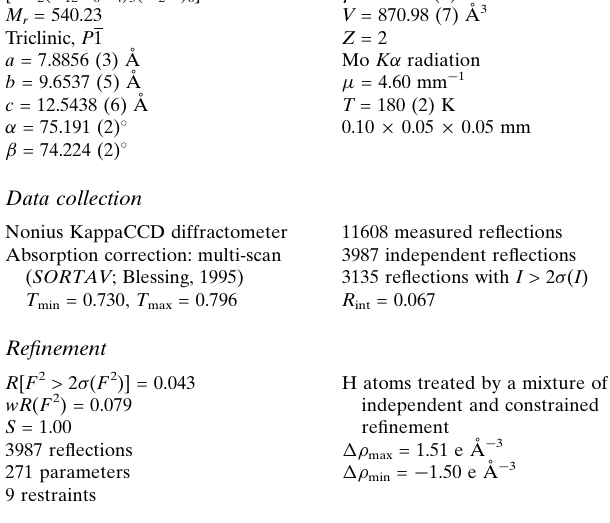
Experimental Crystal data